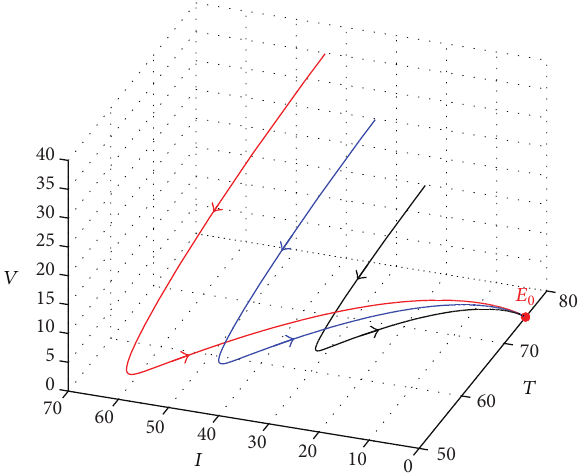
Figure 2: Equilibrium 𝐸 ∗ is locally asymptotically stable when 𝜏 is very small.